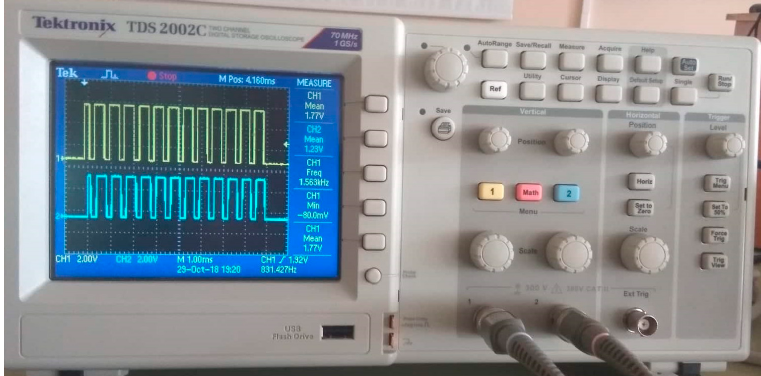
Figure 5. Modulated RF433 transmitter and receiver signa.